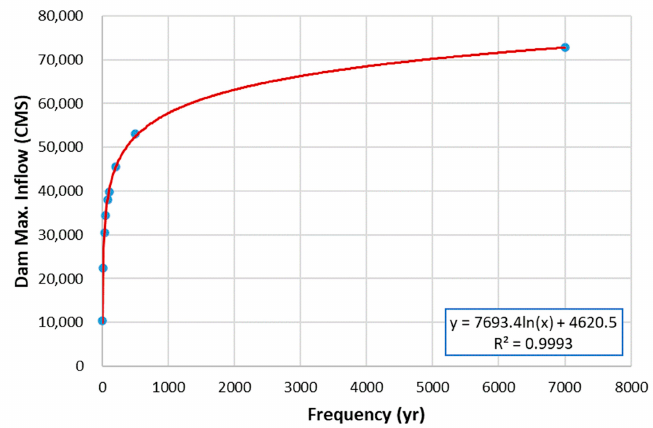
Figure 8. Logarithmic fitting with frequency and peak dam inflow data.